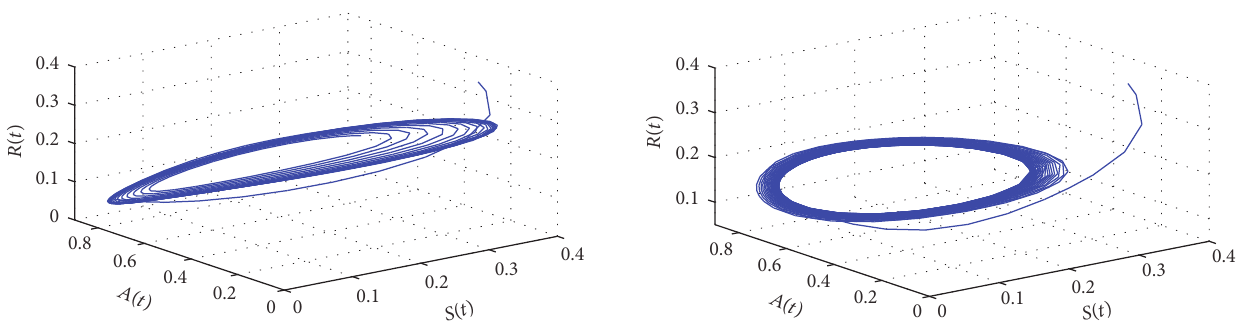
Figure 7: The phase plot of states 𝑆 ∗ , 𝐴 ∗ , and 𝑅 ∗ with 𝜏 2 = 110.96 > 95.9606 = 𝜏 20 .